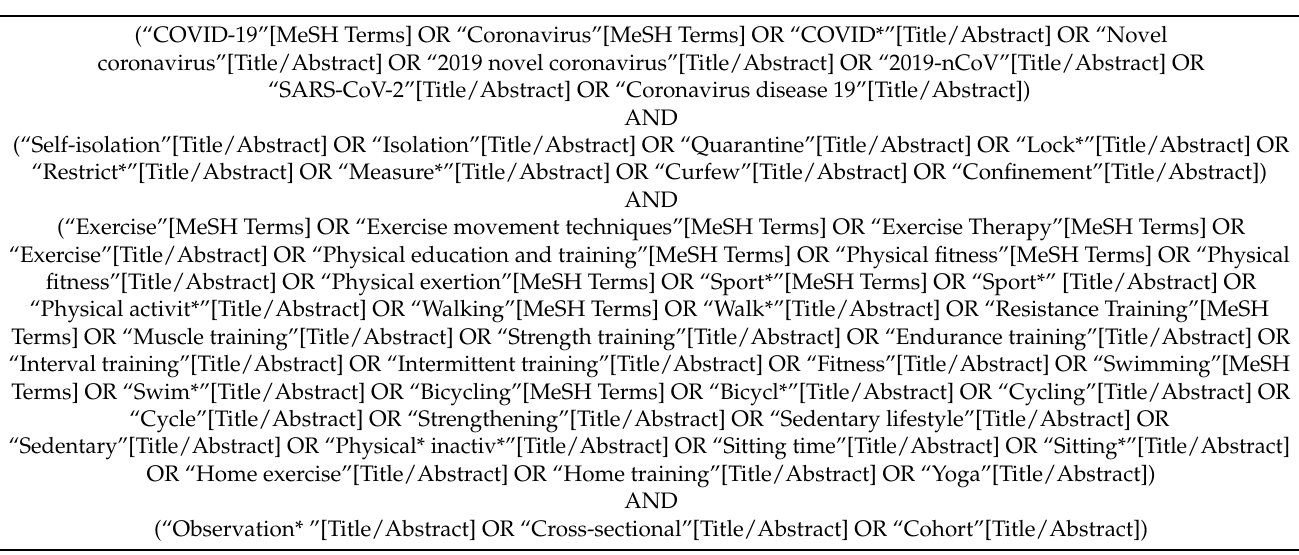
Table 2. PubMed (via MEDLINE) search